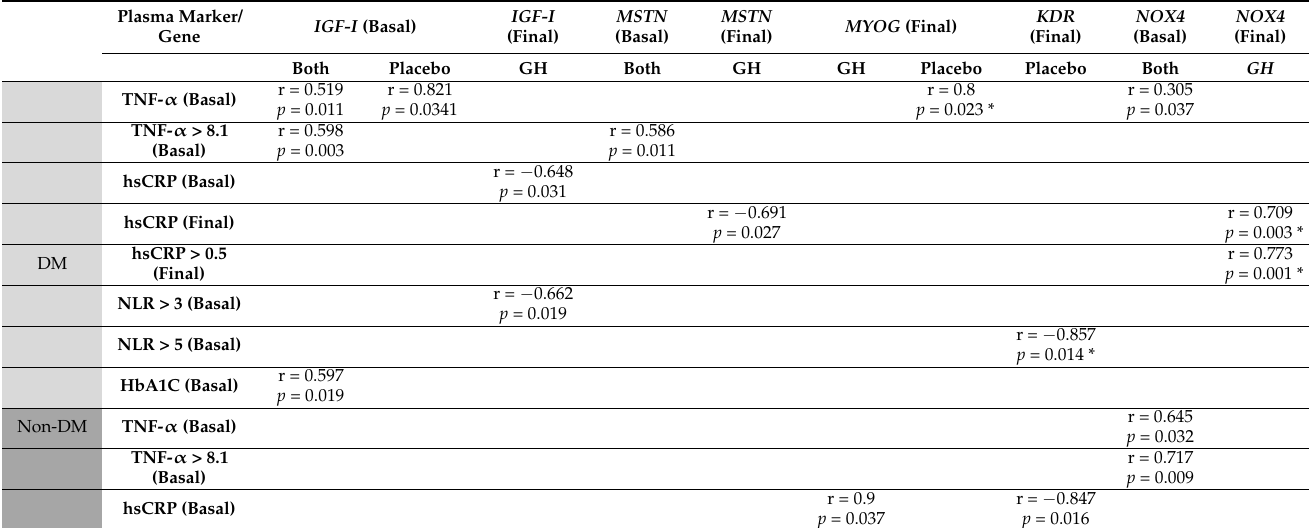
Table 5. Summary of correlations between plasma biomarkers and gene expression of IGF-1 , MSTN , MYOG , KDR , and NOX4 . * Indicates that this condition was also found significantly associ- ated in non-DM population of the GHAS